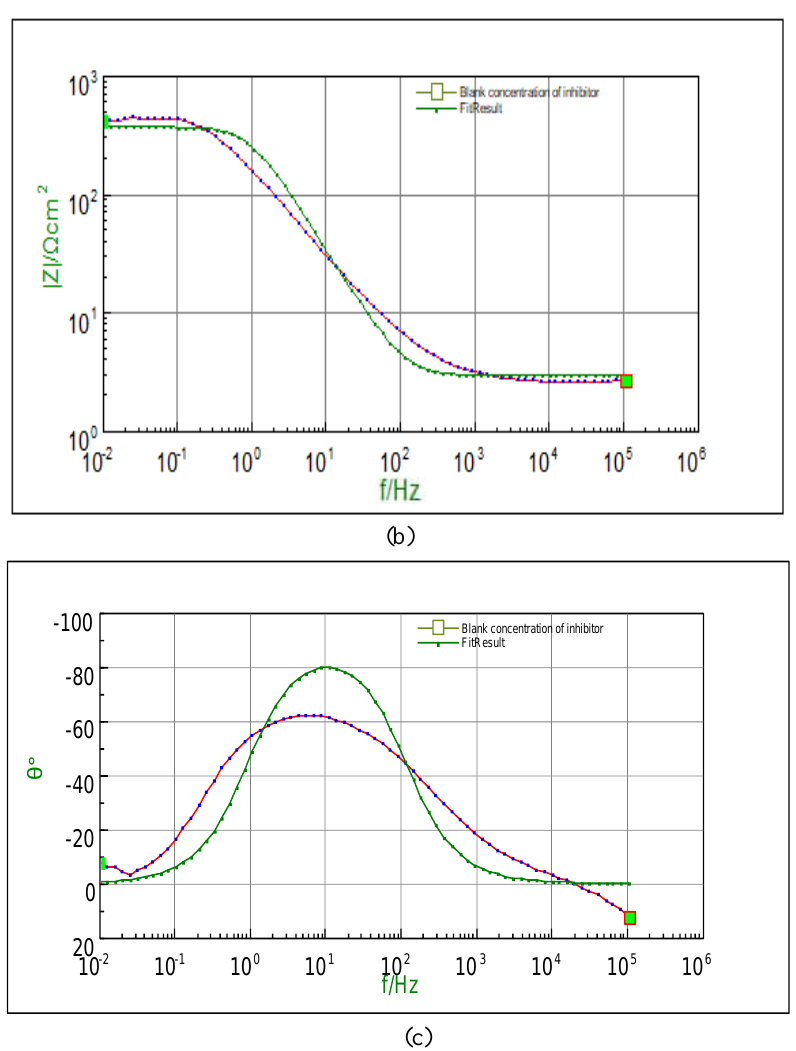
Fig. 10. The EIS test for blank concentration of inhibitor at 55◦C with the fitting result. (a) Nyquist plot, (b, c) Bod (log versus |z|), and phase angle (log f versus ∝ 𝟎 )